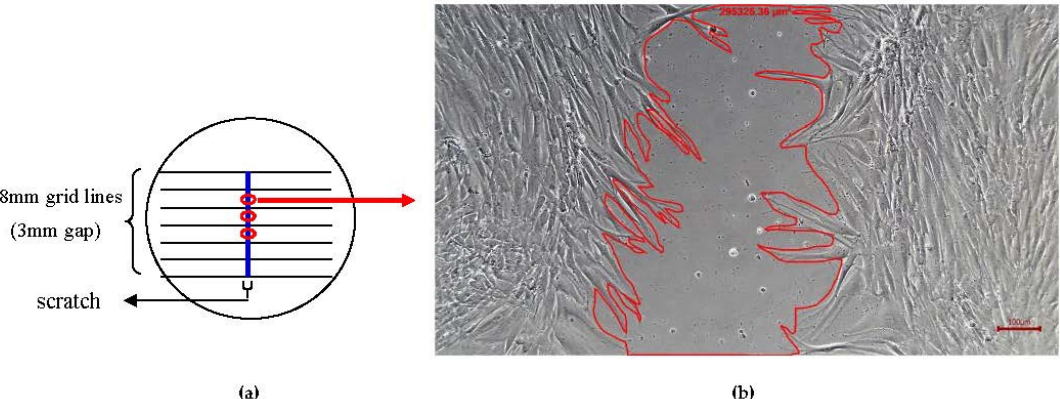
Figure 6. Scratch was made on the confluent monolayer cells to mimic a wound. ( a ) The microscopic images were taken from 3 spots sequentially for 72 h with intervals of 24 h in each group. ( b ) Wound area was measured using Axiovision Version 18.4. The wound area was represented by the cell-free area within the scratch and measured in unit of µm 2 . This microscopic image was taken after treatment with PB-PL at 24 h.